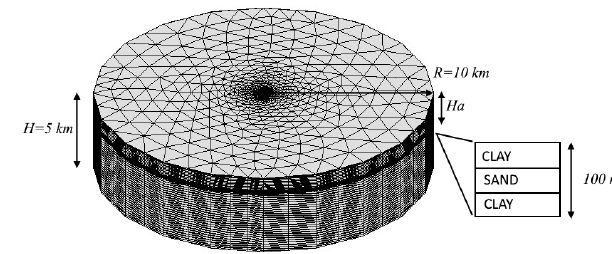
Figure 1. Geomechanical model used in the numerical simulations.